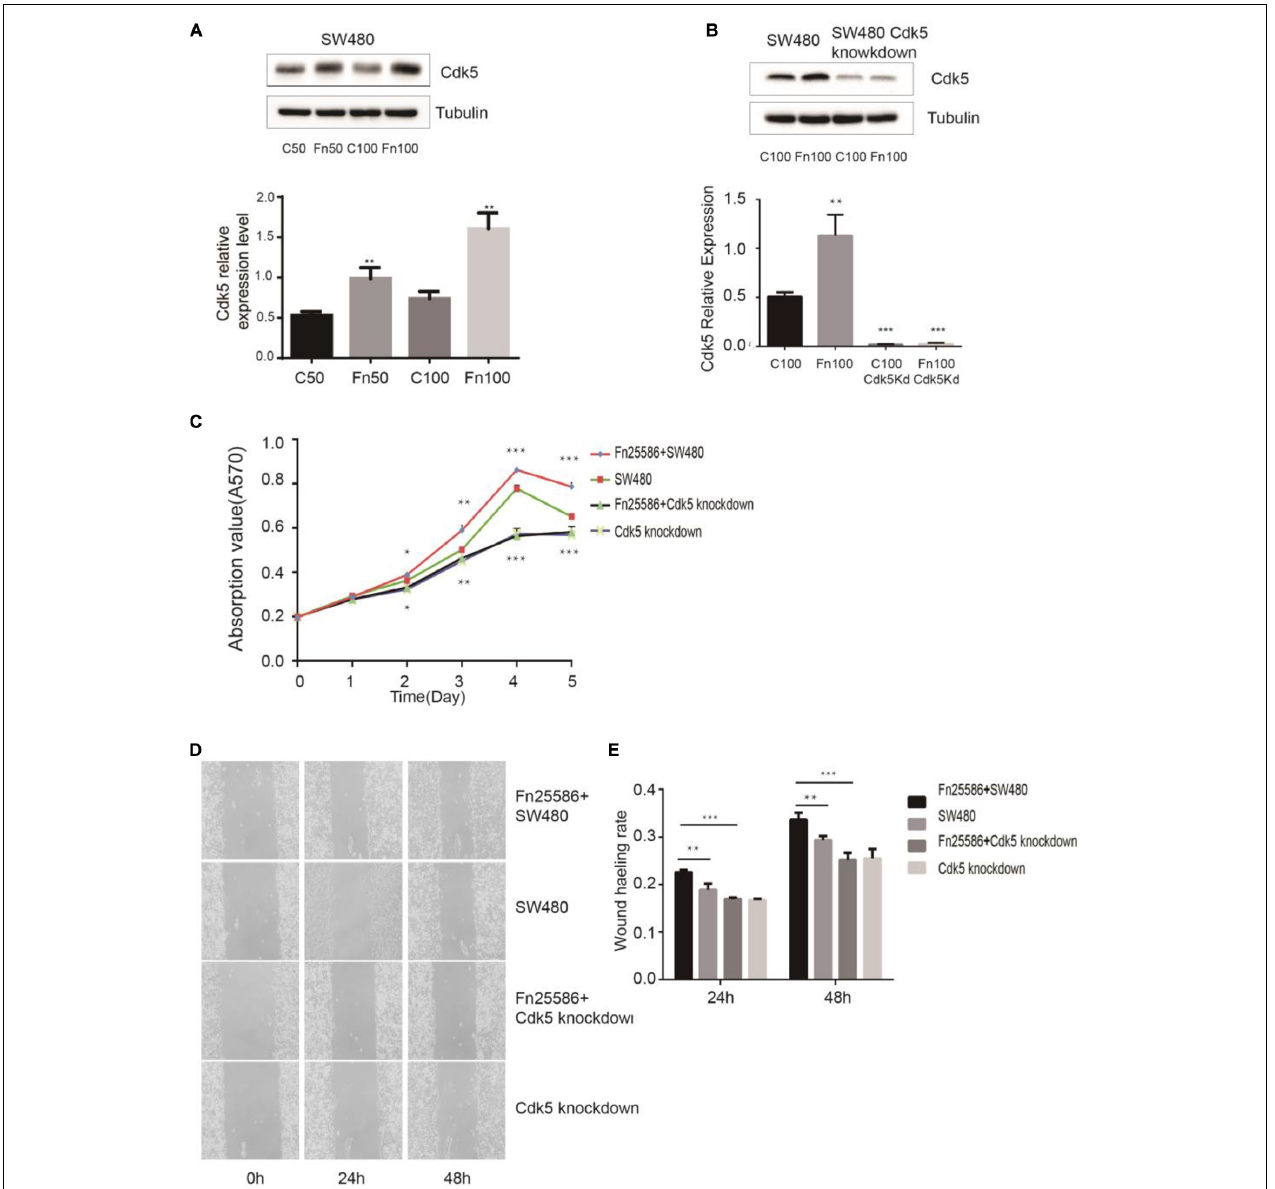
FIGURE 3 | Fusobacterium nucleatum regulates SW480 cancer cell proliferation through upregulated cyclin-dependent kinase 5 (Cdk5) expression. (A) The protein levels and quantification of Cdk5 in SW480 cells treated with F. nucleatum were measured by Western blot (WB) analysis. Data are expressed as mean ± SEM from at least three independent experiments. ** P < 0.01 vs. control. (B) The protein levels and quantification of Cdk5 in SW480 cells and Cdk5-knockdown SW480 cells treated with F. nucleatum were measured by WB analysis. Data are expressed as mean ± SEM from at least three independent experiments. *** P < 0.001 vs. control. (C) F. nucleatum can promote the proliferation of colorectal cancer cells through Cdk5. * P < 0.05, ** P < 0.01, and *** P < 0.001 vs. SW480. (D) Wound-healing assay in SW480 cells and Cdk5-knockdown SW480 cells, respectively, after treated with F. nucleatum ( × 400). (E) Quantification of wound-healing assays. Data are expressed as mean ± SEM from at least three independent experiments. ** P < 0.01 vs. SW480, *** P < 0.001 vs. Cdk5-knockdown SW480.